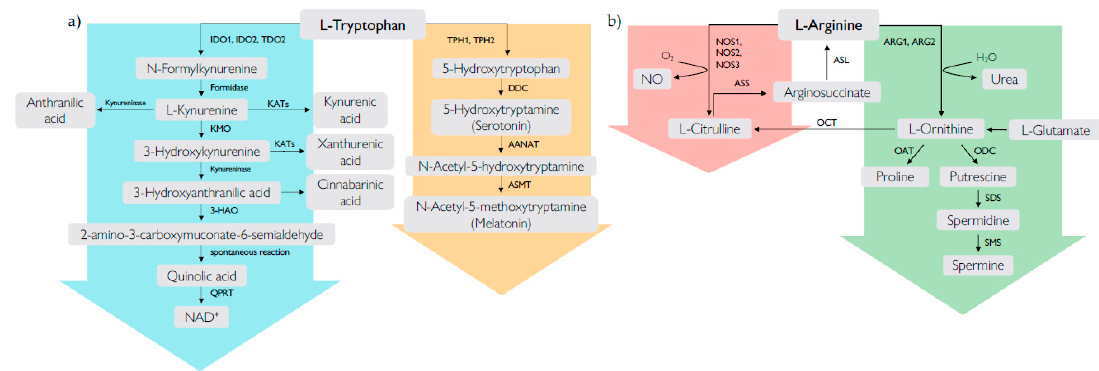
Figure 1. Metabolic pathways of l -tryptophan ( a ) and l -arginine ( b ). ( a ) l -Tryptophan is metabolized by two main pathways, i.e., the kynurenine pathway and the serotonin pathway. The kynurenine pathway (light blue arrow) converts approximately the 99% of ingested l -tryptophan and starts with the transformation of l -tryptophan into N -formylkynurenine by the enzymes indoleamine 2,3-dioxygenase 1 (IDO1), indoleamine 2,3-dioxygenase 2 (IDO2), and tryptophan 2,3-dioxygenase (TDO2). N -Formylkynurenine is rapidly degraded by formamidase to yield l -kynurenine, which is then converted into kynurenic acid, 3-hydroxykynurenine, or anthranilic acid via kynurenine aminotransferase (KATs), kynurenine 3-monooxygenase (KMO), and kynureninase, respectively. 3-hydroxykynurenine is converted into 3-hydroxyanthranilic acid, which is in turn metabolized by 3-hydroxyamino oxidase (3-HAO) into 2-amino-3-carboxymuconate-6-semialdehyde. This metabolite can spontaneously rearrange to form quinolinic acid (QUIN), which is used for the synthesis of nicotinamide adenindinucleotide (NAD + ) via quinolinate phosphoribosyltransferase (QPRT). Additional lateral branches of the kynurenine pathway lead to the formation of other terminal products, including xanthurenic acid and cinnabarinic acid. The serotonin pathway (orange arrow) converts approximately the 1% of ingested l -tryptophan and starts with the transformation of l -tryptophan into 5-hydroxytryptophan by two isoforms of the enzyme tryptophan hydroxylase (TPH1 and TPH2). 5-Hydroxytryptophan is sequentially converted into 5-hydroxy-tryptamine (serotonin), N-acetyl-5-hydroxy-tryptamine (N-acetylserotonin), and N-acetyl-5-methoxytryptamine (melatonin) by the enzymes aromatic amino acid decarboxylase (DDC), arylalkylamine N-acetyltransferase (AANAT), and N-acetylserotonin O-methyltransferase (ASMT), respectively. ( b ) l -Arginine is degraded by two major families of enzymes, i.e., nitric oxide synthases (NOS) and arginases (ARG). NOS exists in three isoforms (NOS1, NOS2, NOS3) and catalyzes the conversion of l -arginine into NO and l -citrulline, which is recycled back into l -arginine by the sequential action of argininosuccinate lyase (ASL) and argininosuccinate synthetase (ASS) (pink arrow). ARG exists in two isoforms (ARG1 and ARG2) and catalyzes the degradation of l -arginine into l -ornithine and urea. l - Ornithine acts as a substrate of ornithine decarboxylase (ODC), ornithine aminotransferase (OAT), and ornithine transcarbamylase (OTC) to yield putrescine, proline, and l -citrulline, respectively. Putrescine is sequentially converted into spermidine and spermine, through the sequential action of spermidine synthase (SDS) and spermine synthase (SMS) (green arrow).